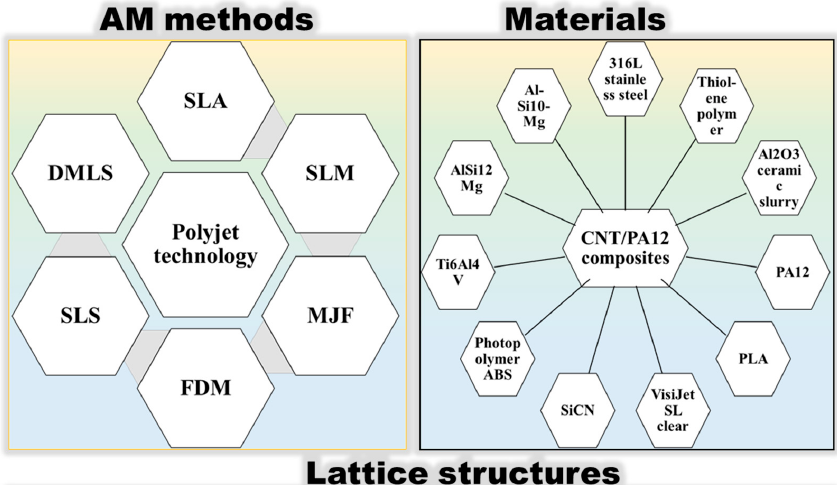
Figure 15 . Interpretation of the predictions of the DL model by ( a ) stacked and ( b ) individual force plots. From the above discussion and analysis, it can be observed that the employed method is applicable to a wide range of materials, AM methods, and lattice structures (see Figure 16). Figure 15. Interpretation of the predictions of the DL model by ( a ) stacked and ( b ) individual force plots.